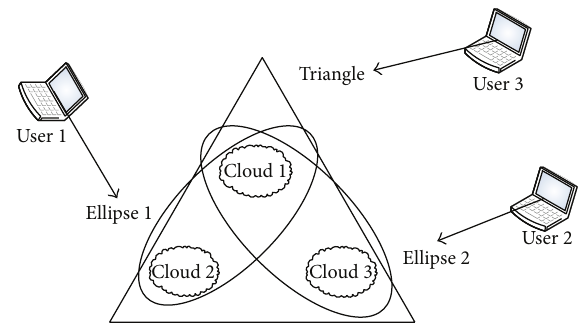
Figure 1: Architecture of cloud